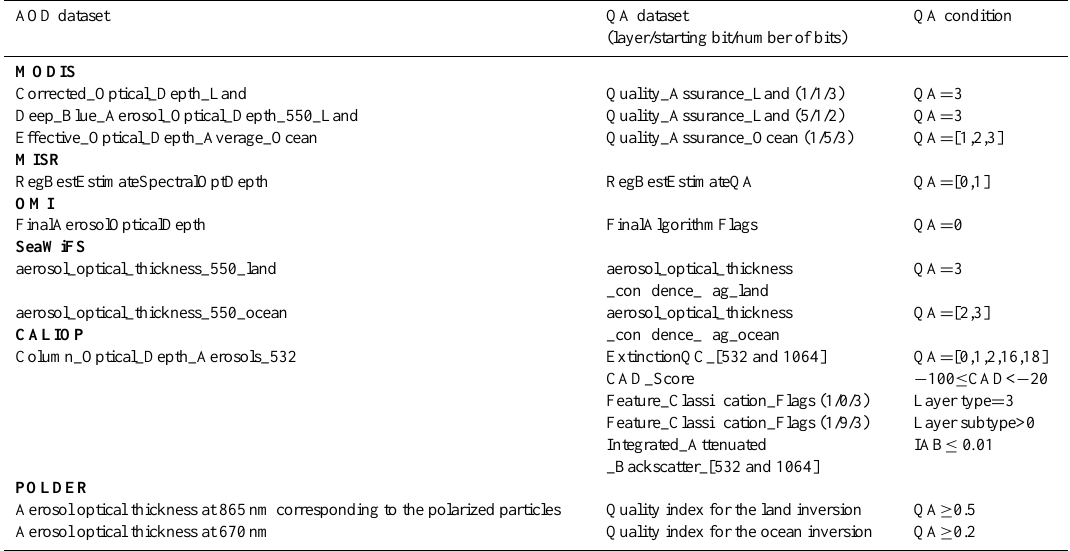
Table 2. Studied aerosol datasets, the matching data quality (QA) datasets, and the corresponding QA data screening criteria. Where provided, numbers in parentheses in the middle column indicate the base-1 layer index, base-0 bit number, and number of bits extracted from this QA dataset. For MODIS, MISR, OMI, and SeaWiFS, the QA values are integer numbers between 0 and 3, whereas for MODIS and SeaWiFS larger numbers indicate a better retrieval quality, and for OMI and MISR the opposite is true. For POLDER, QA is a real number between 0 (worst) and 1 (best). For CALIOP, a column is accepted only if all layers found in this column meet all listed QA conditions. The listed extinction QC values indicate retrievals that are unconstrained, constrained, have a reduced lidar ratio, or detected an opaque aerosol layer. CAD score and layer type and subtype flags indicate retrievals that classified a layer with a high confidence as containing aerosol and were able to determine the aerosol type. IAB condition is set to prevent the retrieval anomaly of overcorrecting the attenuation of overlying layers (Kittaka et al.,